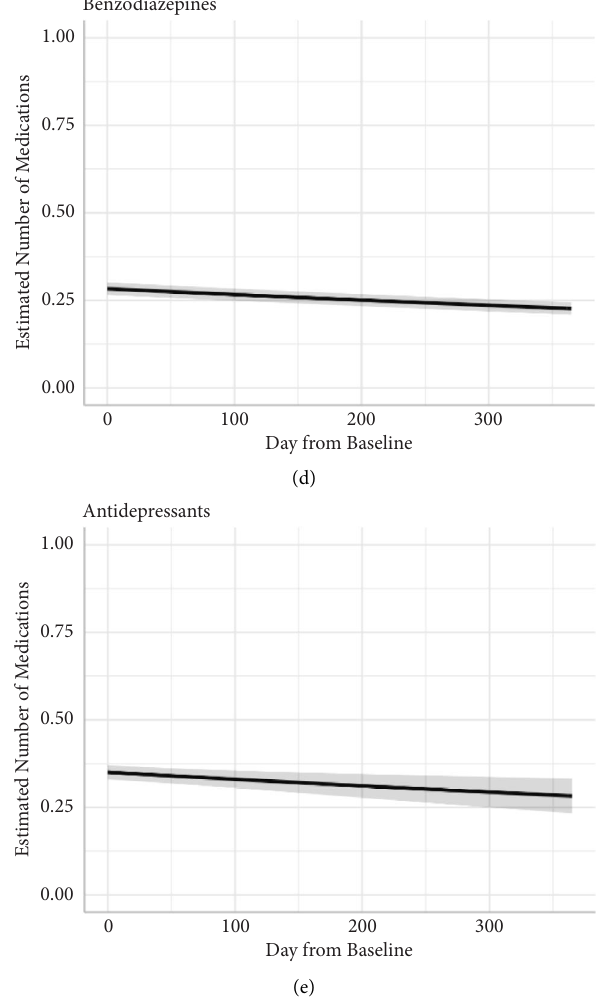
Figure 1: Estimated trajectories for one-year change in the number of total medications and number of medications in specifc